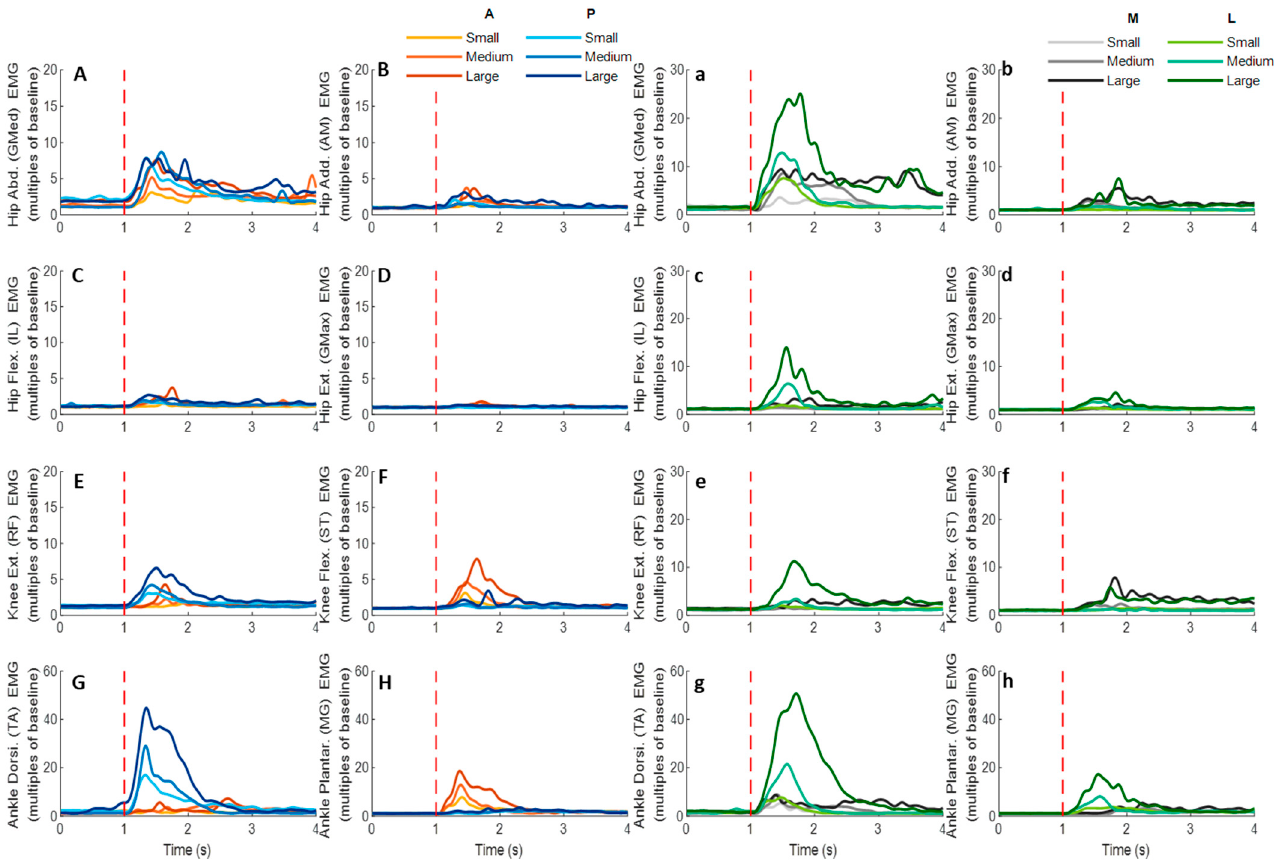
Figure 12. The mean EMG signal changes of twelve participants for eight dominant-leg muscles following the unexpected anterior, posterior, medial, and lateral perturbations with three magnitudes ( n = 12). Mean EMG signal changes for hip abductor-adductor ( A , B ), hip flexor-extensor ( C , D ), knee extensor-flexor ( E , F ), and ankle dorsiflexor-plantarflexor ( G , H ) following anterior and posterior perturbations; Mean EMG signal changes of hip abductor-adductor ( a , b ), hip flexor-extensor ( c , d ), knee extensor-flexor ( e , f ), and ankle dorsiflexor-plantarflexor ( g , h ) following medial and lateral perturbations. (Note: The EMG amplitude values were multiples of the 1000-ms baseline mean value before a pulling perturbation. The red dotted line indicated the start of pulling perturbation. EMG : electromyography. GMed : gluteus medius; AM : adductor magus; IL : iliopsoas; GMax : gluteus maximus; RF : rectus femoris; ST : semitendinosus; TA : tibialis anterior; MG : gastrocnemius